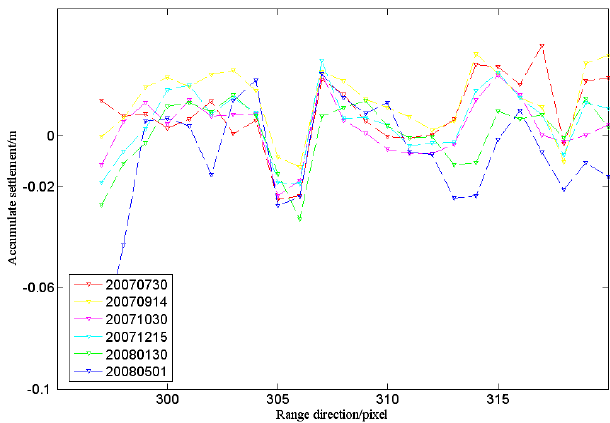
Figure 7.Time series settlement profile of subsidence funnel C in distance